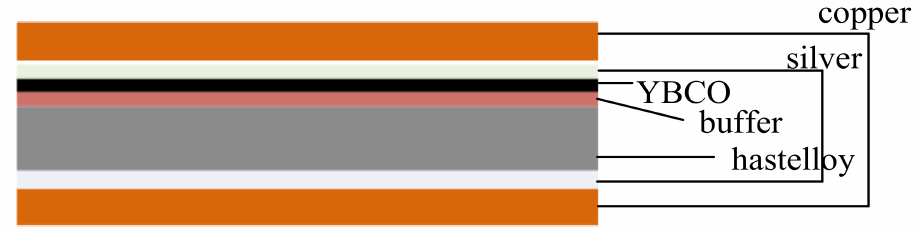
Figure 1. Typical configuration of 2G HTS